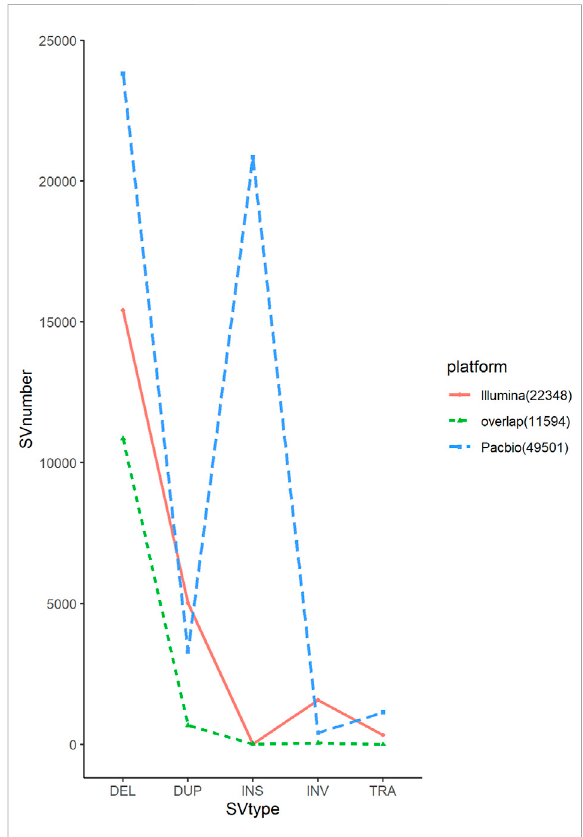
FIGURE 2 Comparison of structural variations in PacBio and Illumina sequencing